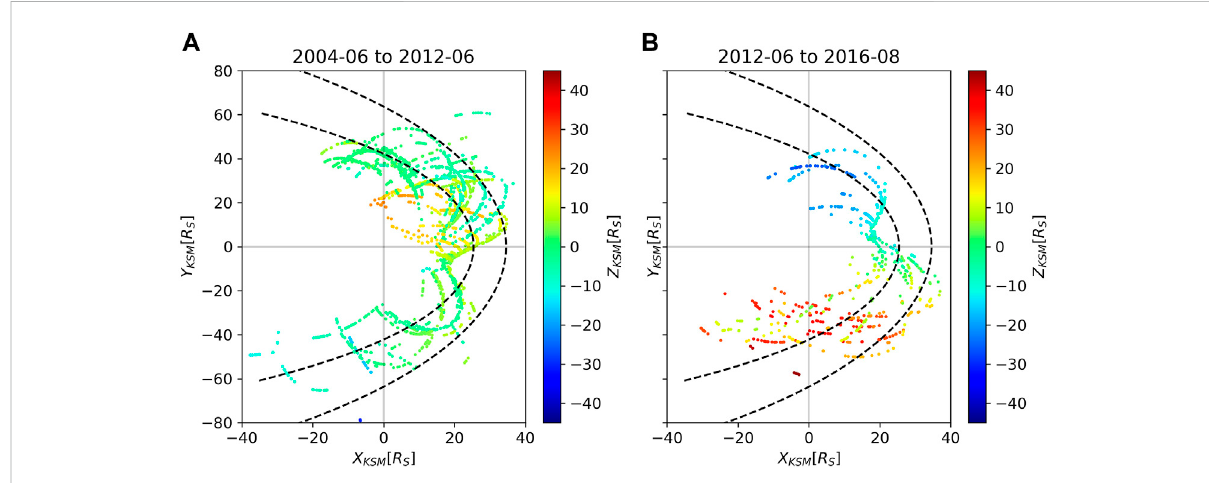
FIGURE 5 ThepositionsofBSandMPcrossingsasobservedbyCassini. (A) 2004 – 2012waswhenCAPSdatawerelargelyavailable,andtheorbitscovered allofpre-equinox,equinoxand2 yearsofthesolsticemission. (B) 2013 – 2016waswhenonlyMAGdatawereavailable,whichcoveredtheremaining part of the solstice